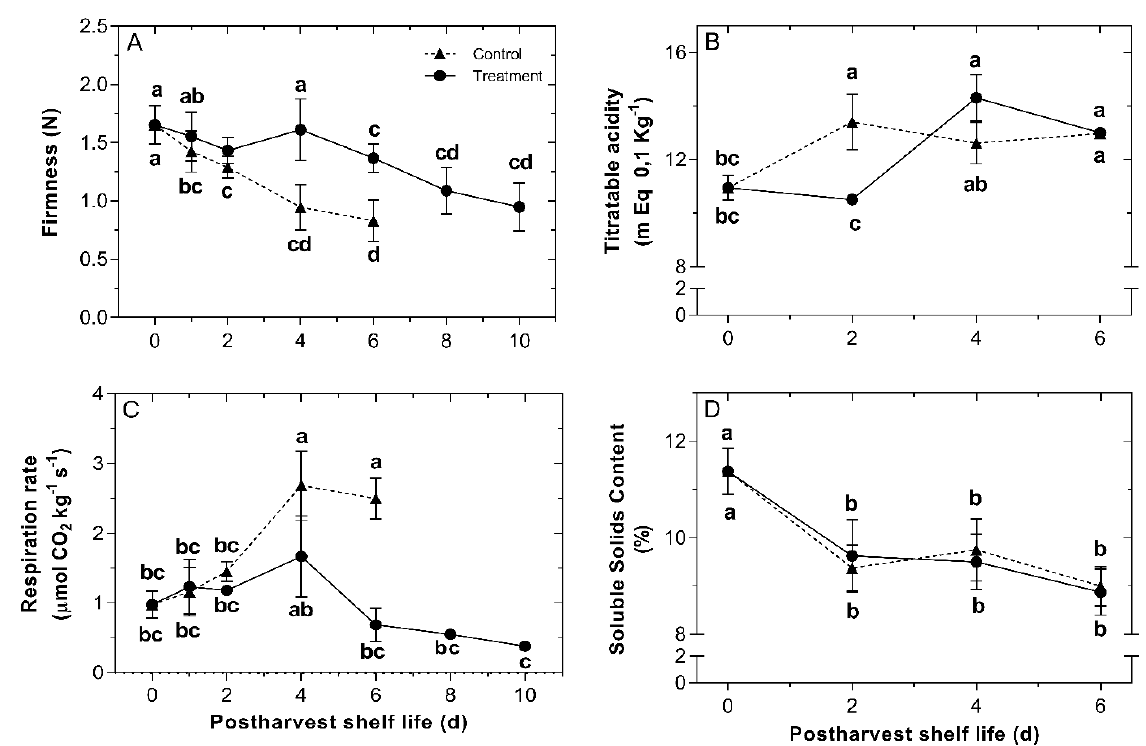
Figure 3. Effects of H 2 S treatment on firmness, titratable acidity, respiration rate and soluble solids content during postharvest shelf-life of Chilean strawberry ( Fragaria chiloensis ) fruit. Strawberries were treated after harvest with 0.2 mM H 2 S donor NaHS. Changes in ( A ) fruit firmness; ( B ) titratable acidity; ( C ) respiration rate, and ( D ) soluble solids content. Each value is the mean of three replicates and vertical bars represent standard errors. Different letters indicate significant differences at p < 0.05. For details, see Section